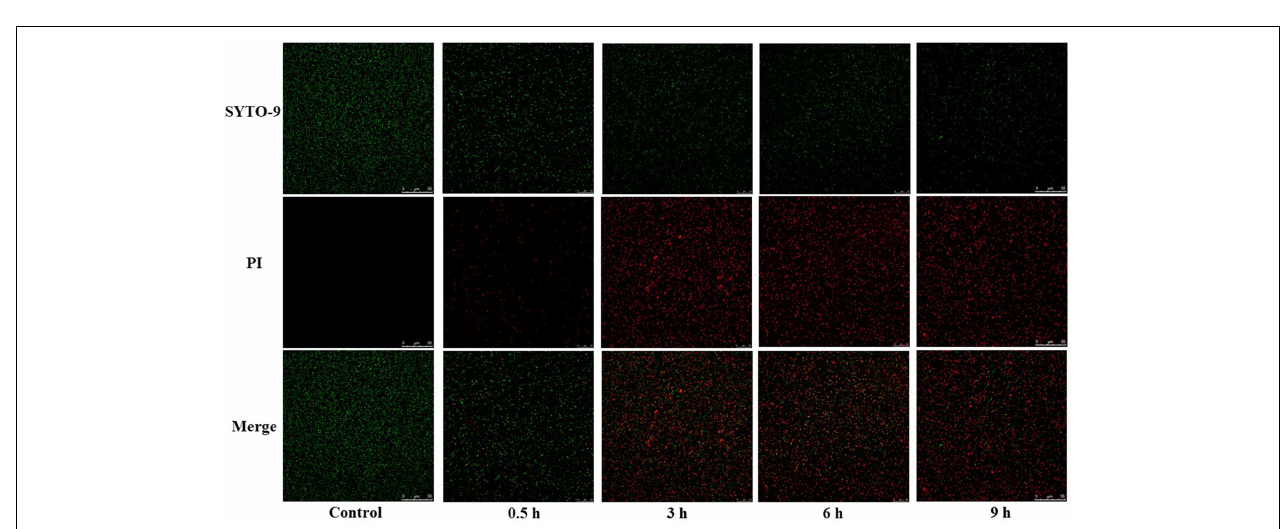
FIGURE 4 | Flow cytometry plots of Y. enterocolitica after CA treatment.